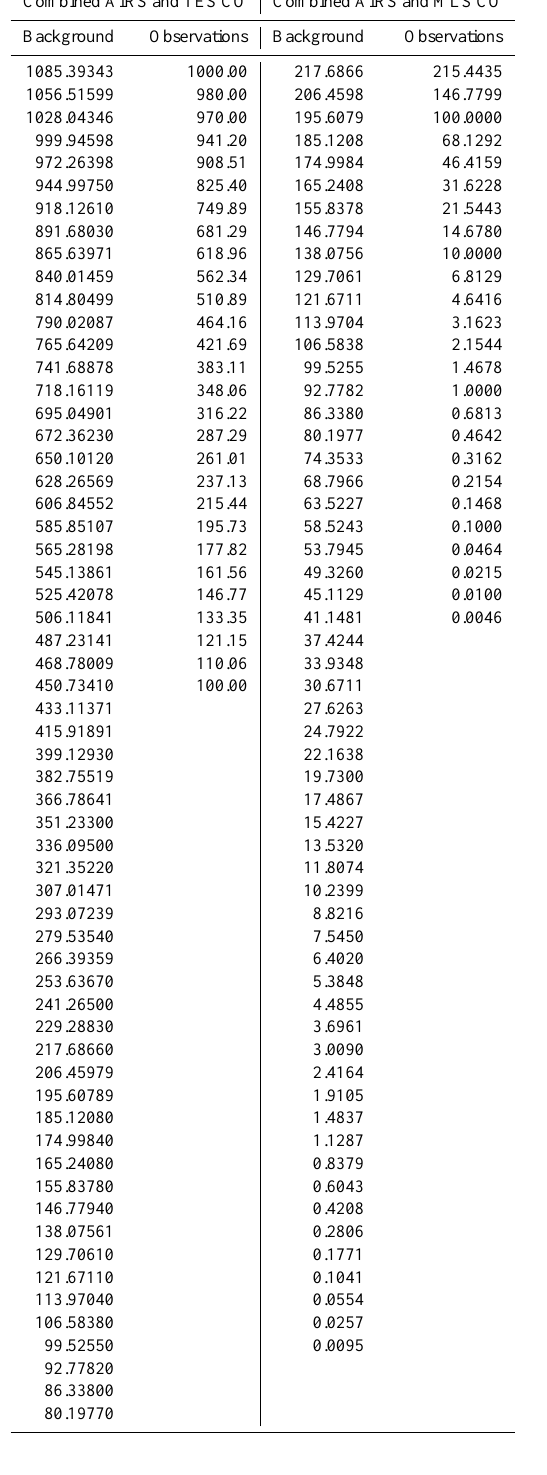
Table 1. The pressure levels used in combined AIRS (background and analysis) and TES (observations) CO (left columns), and com- bined AIRS (background and analysis) and MLS (observations) CO (right columns).